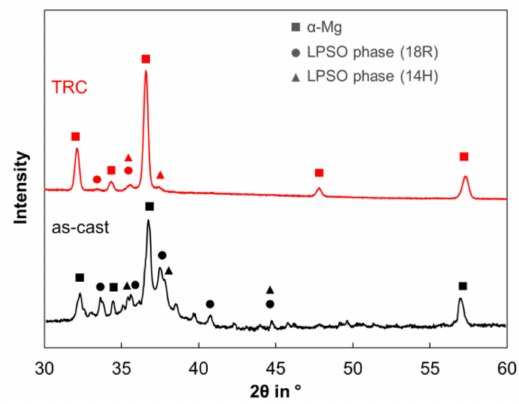
Table 2. Chemical composition of microstructural constituents from the as-cast and the TRC con- dition in Figure 2 (A, C — magnesium matrix, B, D — network-like LPSO structures) determined by means of energy dispersive X-ray spectroscopy (EDX)-analysis (wt.%).